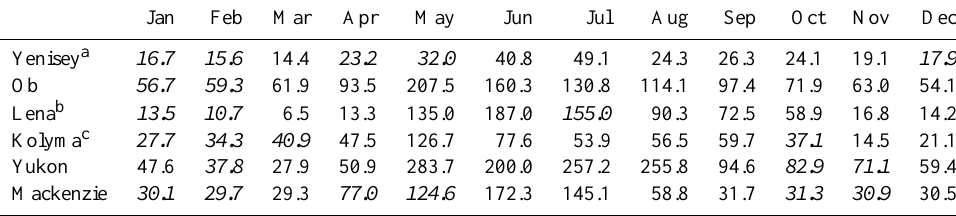
Table A7. Monthly-binned riverine concentrations of POC (mmolCm − 3 ) . Linearly interpolated values are shown in italic.